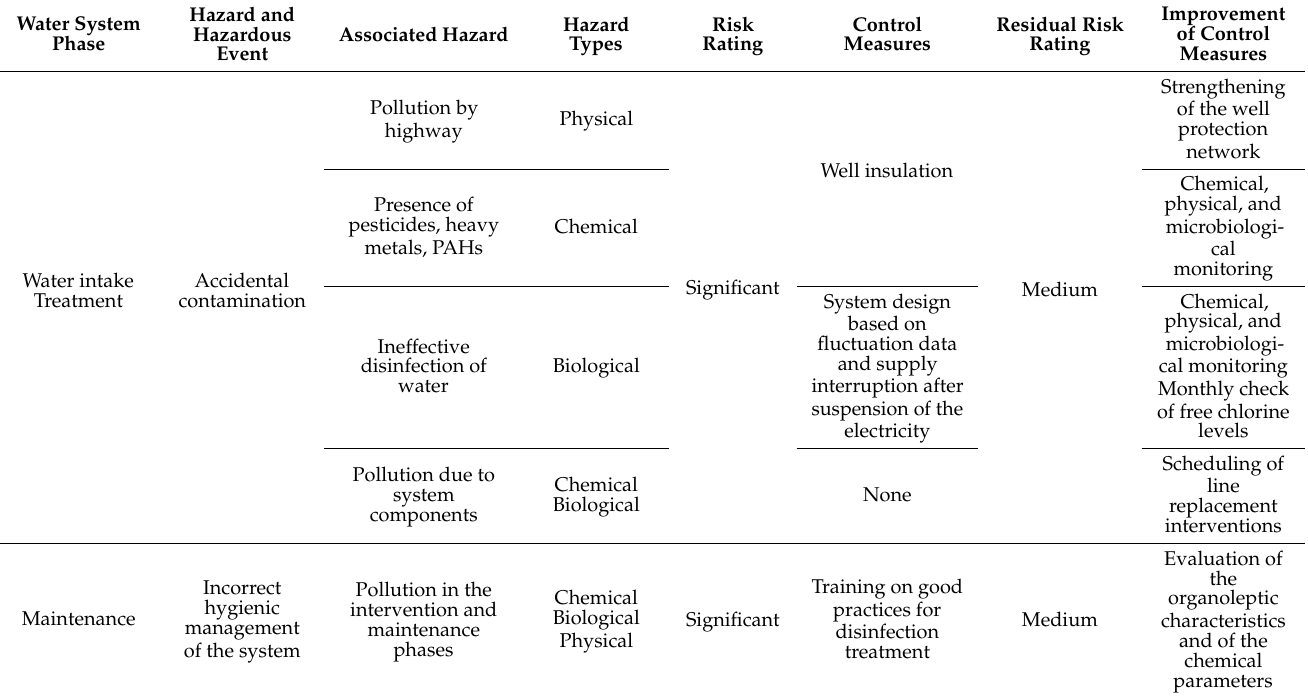
Table 4. Identification of hazards and dangerous events: Case Study 2—Artesian well line.